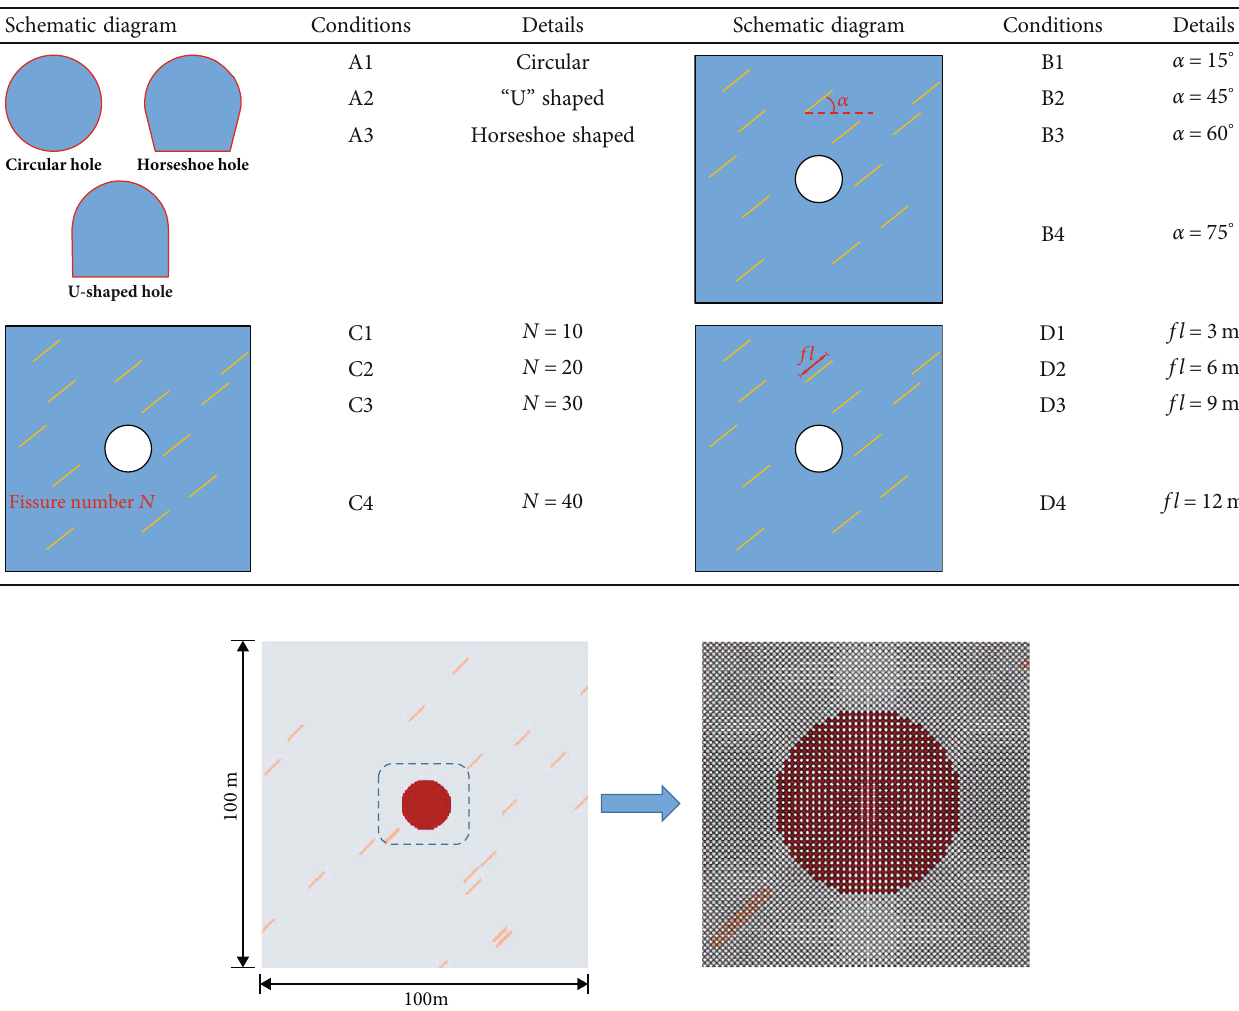
Figure 4: IKSPH numerical model and particle distributions.